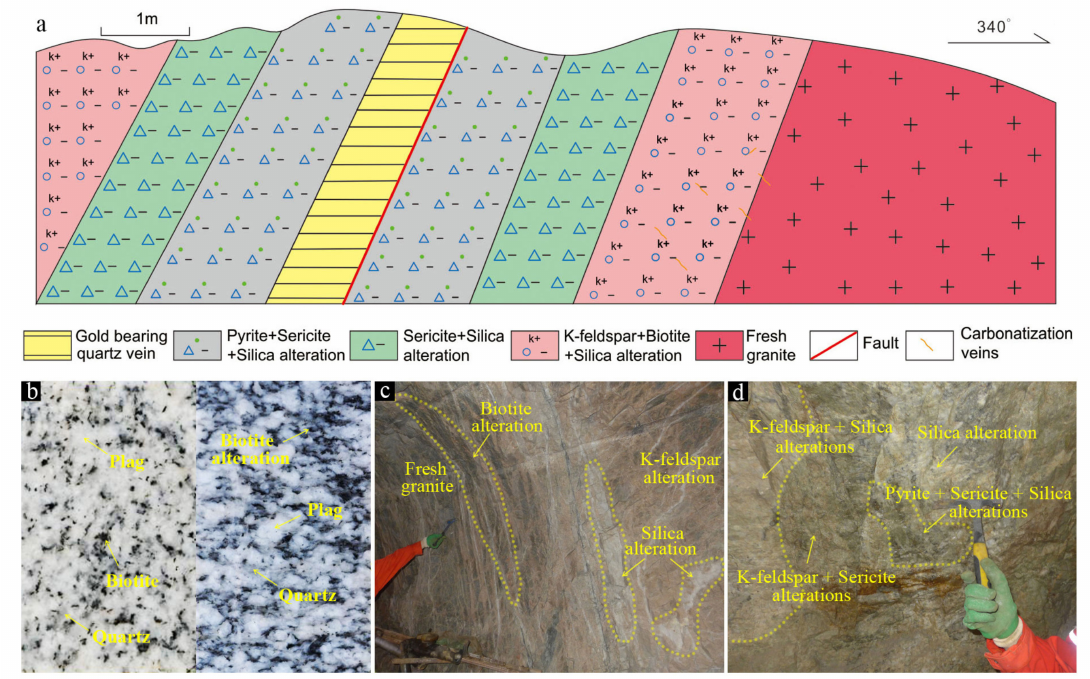
Figure 2. A sketch of alteration zonation ( a ) and alteration styles at the Linglong goldfiled ( b – d ). ( b ) fresh biotite granite (left) and granite with biotitization. ( c ) Pink to flesh pink potassic alterations developed in the biotite granite and were overprinted by silicic alteration. ( d ) Silicification with local pyritic alteration. Plag: